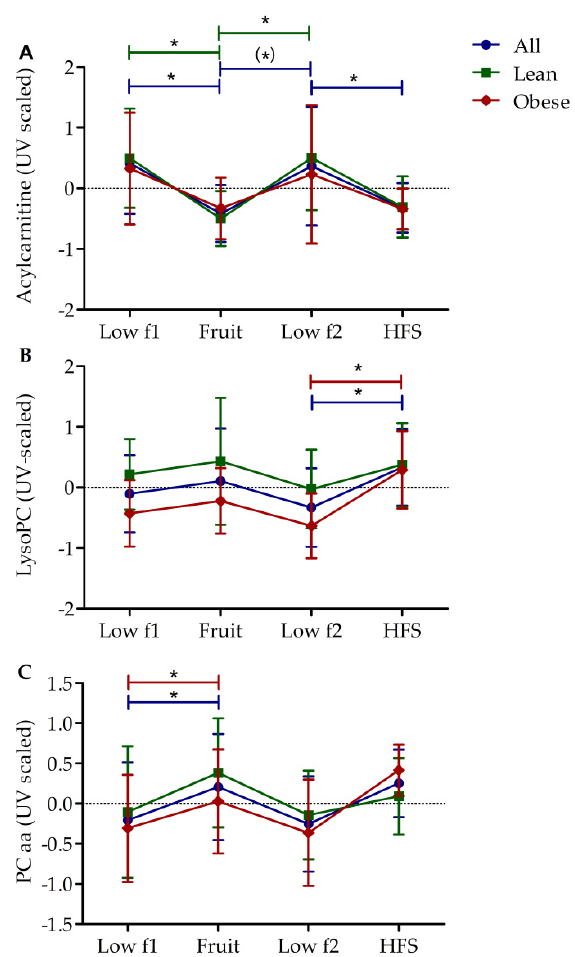
Figure 3. Changes of metabolite levels within study phases. Mean ( ± SD) of ( A ) medium and long chain acylcarnitine levels, ( B ) lysoPC levels, ( C ) PCaa levels after unit variance (UV) scaling of all ( n = 12), lean ( n = 6) and obese ( n = 6) subjects are shown for four study phases (explained in Figure 1). Significant differences between phases are indicated as * adj. p < 0.05. Trends are indicated as (*) adj. p < 0.1.